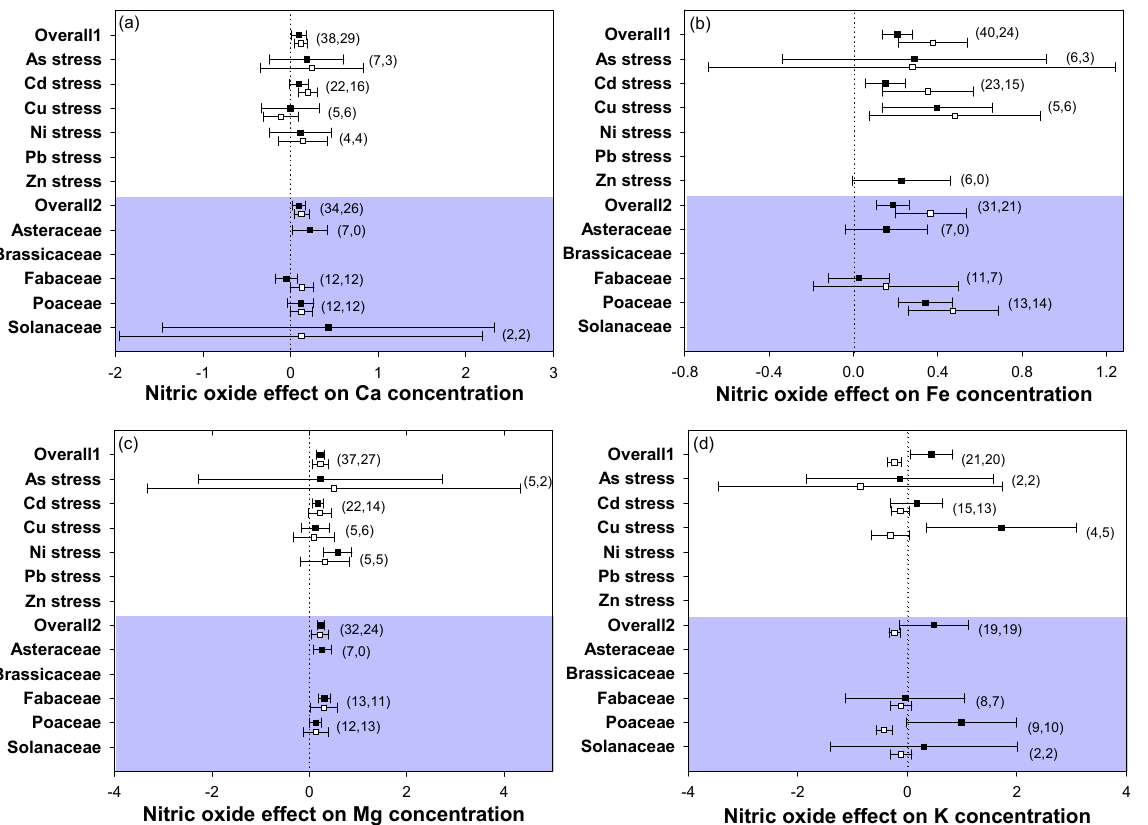
Figure 5. Plots of effect sizes for the effect of NO on element accumulation of metal-stressed plants, including ( a ) Ca, ( b ) Fe, ( c ) Mg, and ( d ) K. Overall1 and overall2 indicate the mean (summary) effect size of all metal stresses and plant families, respectively. Black and white dots indicate the mean effect sizes for factor groups of leaf and root responses, respectively. The numbers in brackets specify the number of data points. The black square block with the error bar indicates the mean response size with a 95% confidence interval, and the dashed vertical line shows zero effect.